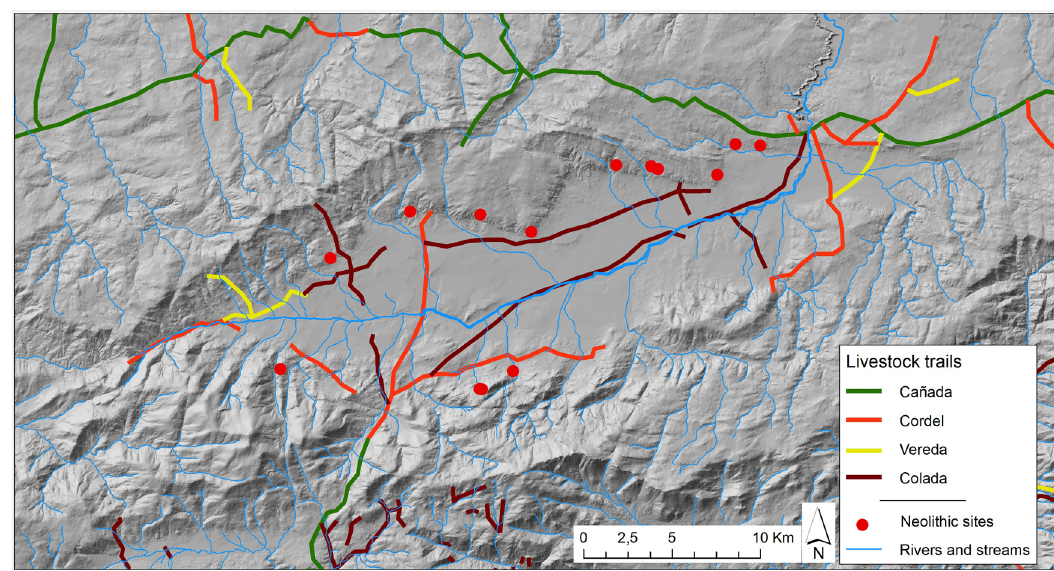
Figure 3: Map showing the existing livestock trails and the location of the Neolithic settlements in the Amblés